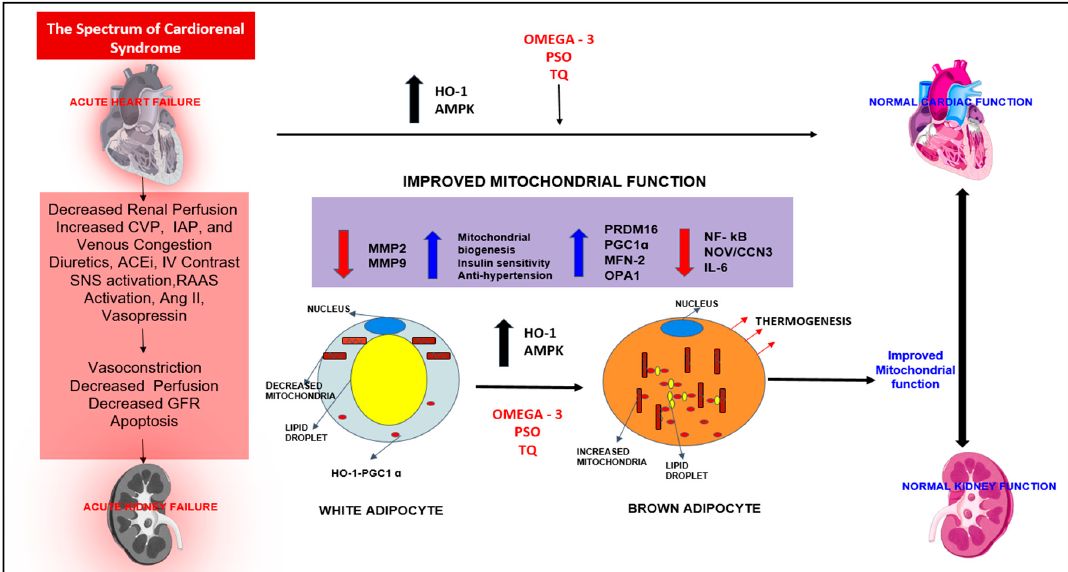
Figure 7. The spectrum of cardiorenal syndrome. This is a schematic representation of how HO-1 upregulation results in improved mitochondrial function and signaling pathways PGC1 α , PRDM 16, OPA1, and MFN-2. Upregulation also results in decreased inflammatory adipocytokines (NOV / CCN3, IL-6, and NF-kB) and fibrotic markers (MMP2 and MMP9). The result was the “browning” of white adipocytes to “beige”, improving cardiac and renal functions. HO-1 = heme oxygenase 1; AMPK = AMP-activated protein kinase; PSO = pomegranateseedoil; TQ = thymoquinone; NF-kB = nuclearfactorkappa-light-chain-enhancer of activated B-cells; NOV / CCN3 = nephroblastoma overexpressed; IL-6 = interleukin 6; MMP2 = matrix metalloproteinase 2; MMP9 = matrix metalloproteinase 9; PRDM16 = PR domain containing 16; PGC-1 α = peroxisome proliferator-receptor gamma coactivator 1 α ; MFN-2 = mitofusin-2; OPA1 = mitochondrial dynamin-like